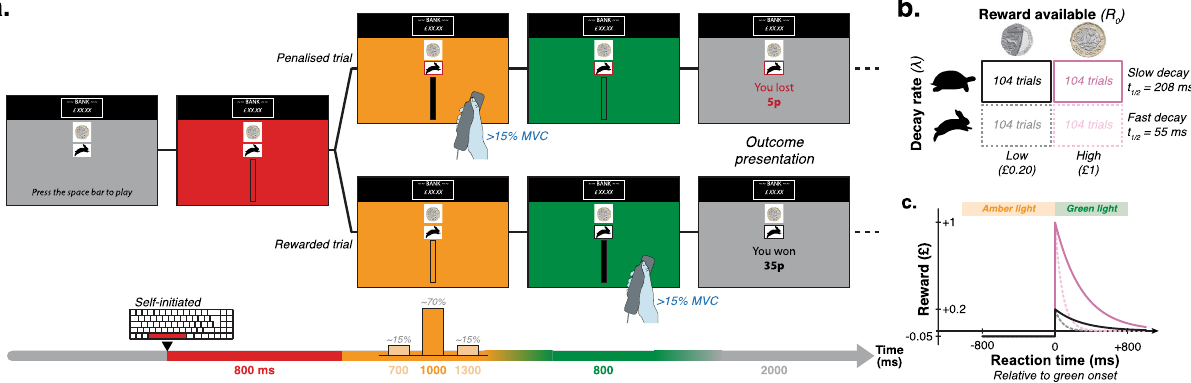
Figure 2. Overview of the Traffic Light Task. ( a ) A picture of a coin ( £ 1, £ 0.20) and an animal (turtle, hare) indicated the reward magnitude and decay rate for the upcoming trial. Pressing the space bar initiated the sequence of red, amber, green background colours. The duration of the amber light was either 700 ms (15.38% of trials), 1000 ms (69.23% of trials) or 1300 ms (15.38% of trials). Participants won monetary reward by squeezing a hand-held dynamometer above 15% of the Maximum Voluntary Contraction (MVC) as quickly as they could after the background turned green. ( b ) Both the intercept ( R 0 ) and decay rate ( (cid:31) ) of the exponential reward function were experimentally manipulated in a two-by-two design (104 trials per condition in total, uniformly spread across eight experimental blocks). ( c ) Visual representation of the reward function of the